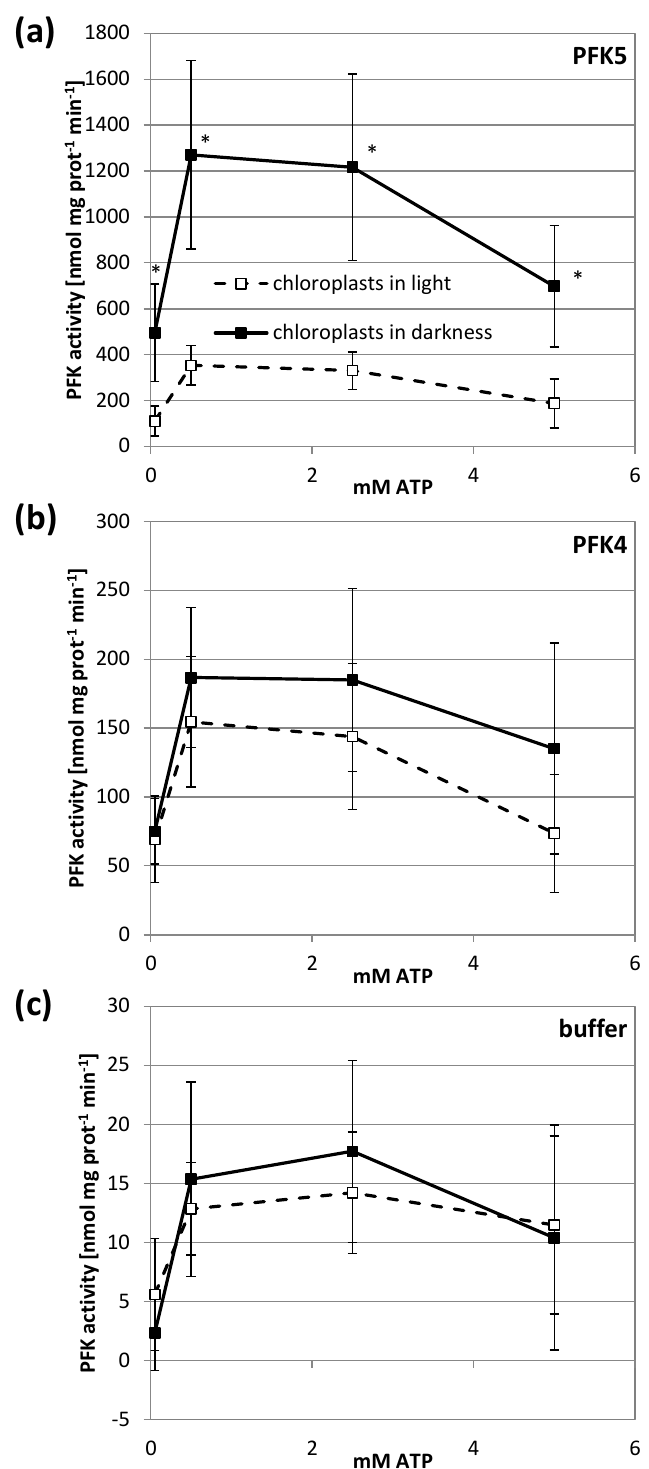
Figure 6. Light inactivation of AtPFK5 in tobacco chloroplasts. AtPFK5 ( a ) and AtPFK4 ( b ) were transiently overexpressed in tobacco leaves. Leaves expressing AtPFK4 as well as plants infiltrated with the infiltration buffer ( c ) were used as negative controls. Chloroplasts were isolated and illuminated with 1000 µmol photons . m − 2 s − 1 for 1 h ( □ ) or kept in darkness ( ■ ). PFK activity was measured under various ATP concentrations. The results are means ± SD of n = 10. Significant differences between light and darkness treatment at each ATP concentration are marked with asterisks (*) ( t -Test, p < 0.001).